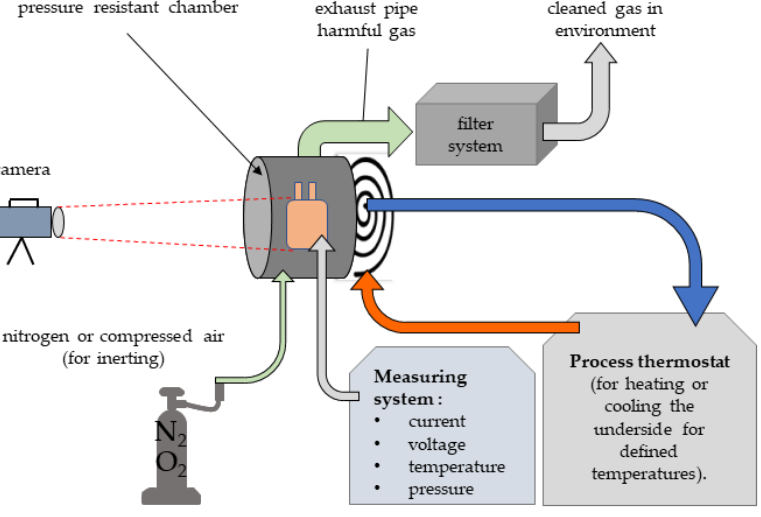
Figure 10. Overview Test setup.